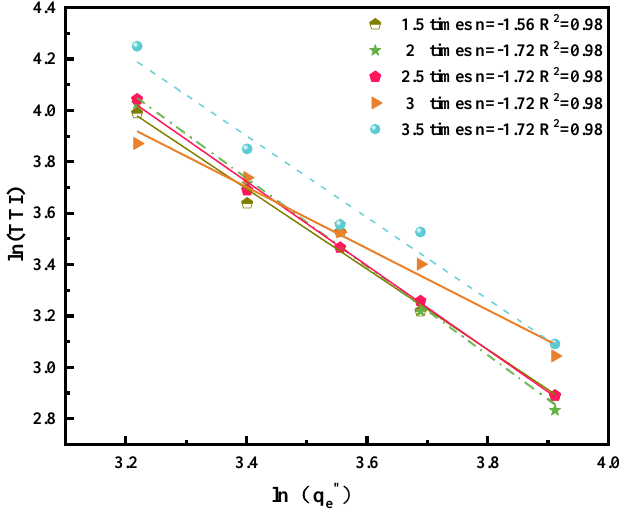
(cid:0) . (cid:1) q (cid:48)(cid:48) fitted e